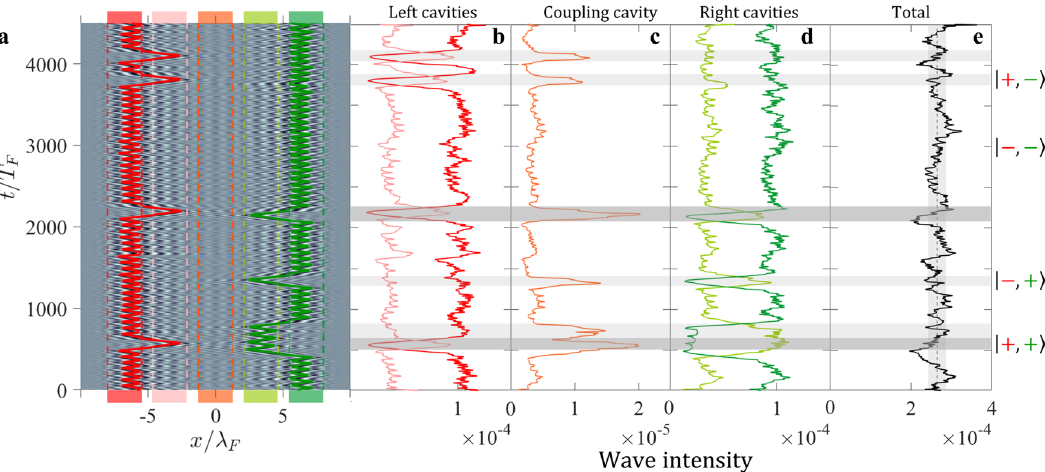
Fig. 4 Wave intensity. a The particle paths and associated wave fi elds. Light and dark regions correspond to wave minima and maxima, respectively. b – e The associated wave intensity, as computed from Supplementary Eq. (3). Comparison of ( a ) and ( b ) reveals the correlation between extrema in the wave intensity and the tunneling events. In ( b – e ), intervals in which one or both drops are in an excited state are denoted by light and dark gray, respectively, and are correlated with local extrema in the total wave